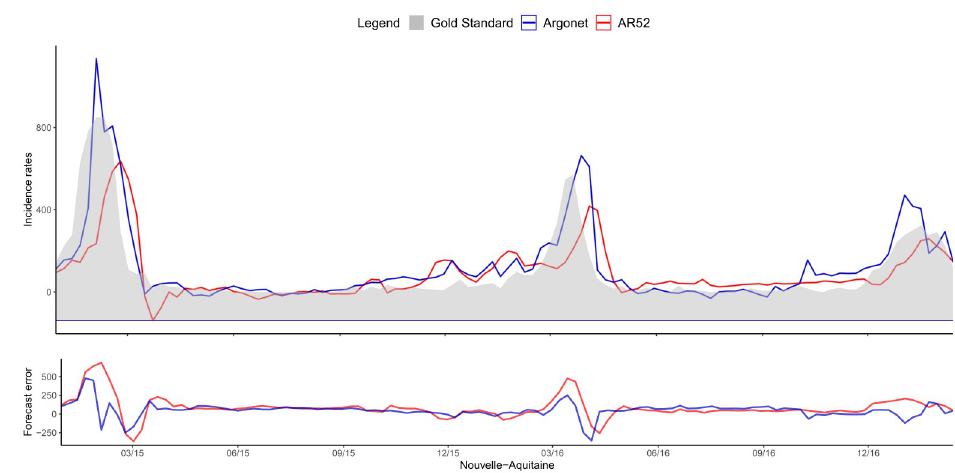
Fig 12. Coefficients Nouvelle-Aquitaine one-week ahead estimate.